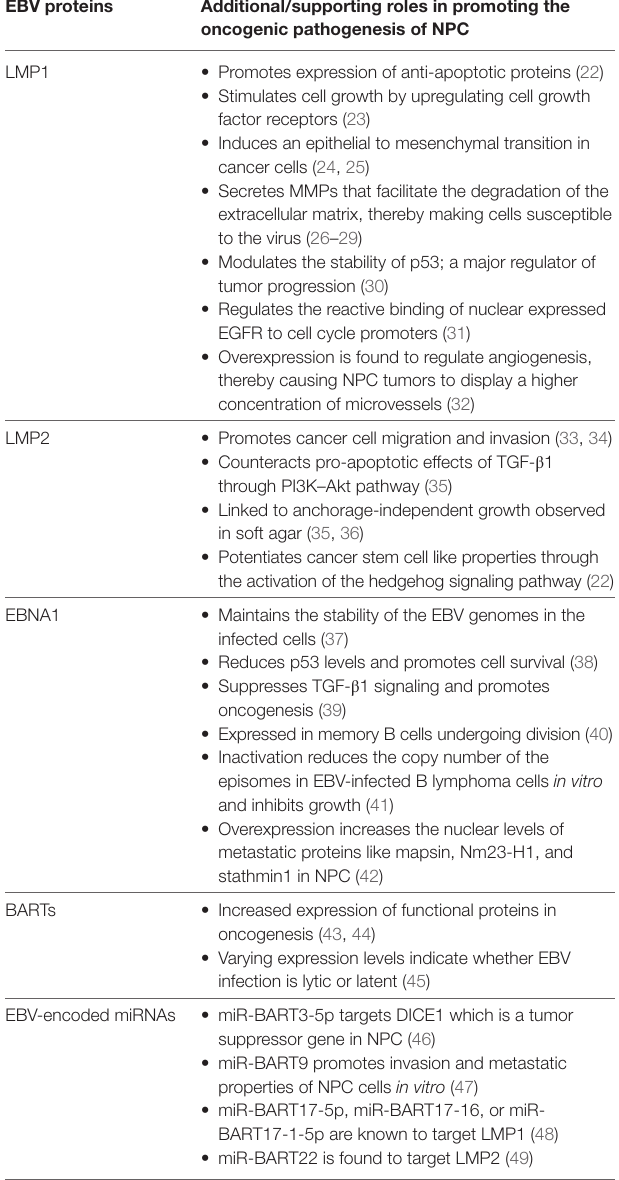
TABLe 1 | EBV-associated proteins and miRNAs involved in the pathogenesis of NPC. eBv